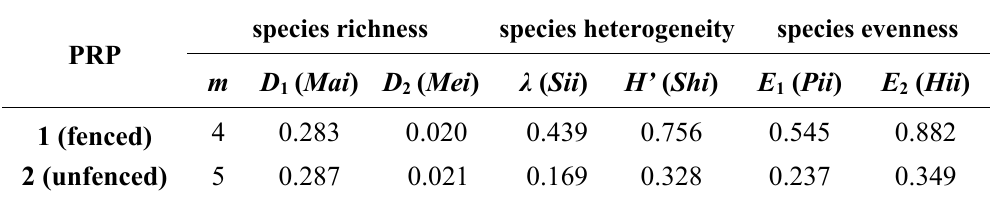
Table 4. Indices describing the species biodiversity of natural regeneration.